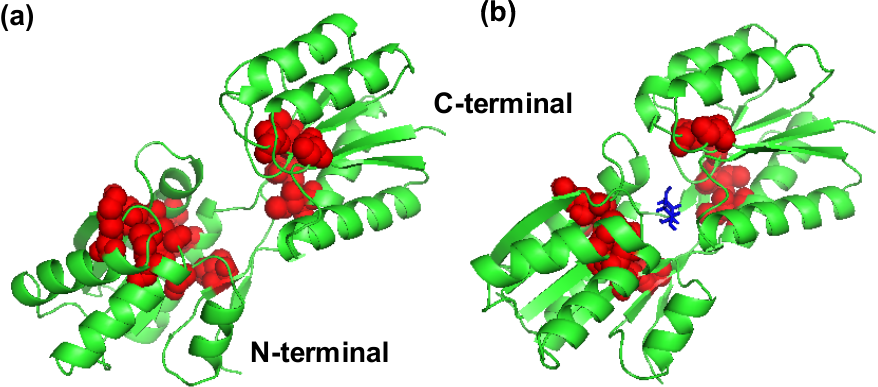
Figure 1. Ribose-binding protein (RBP) in ( a ) an open ligand-free conformation (PBD: 1URP) and ( b ) a closed ligand-bound conformation (PDB: 2DRI), the ribose is marked in blue. The peak residues are marked in red. All the peak residues form a contiguous cluster distributed on the surface of RBP facing the ribose-binding